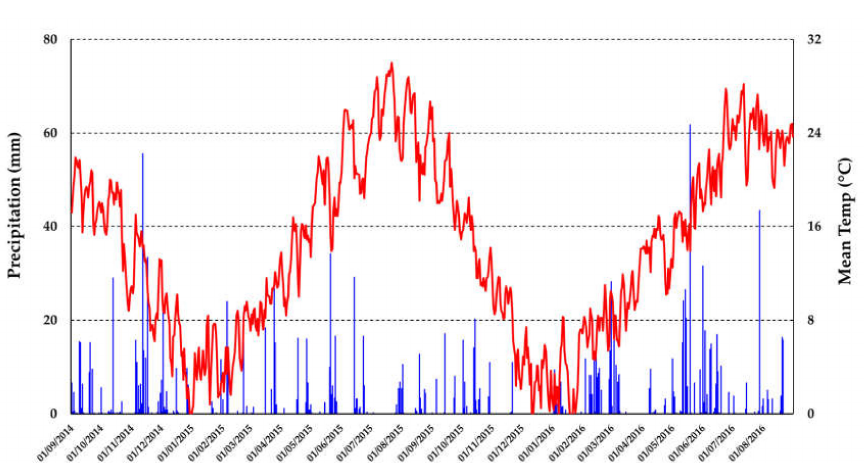
Figure 2. Meteorological data recorded during the two years of tests: daily precipitation recorded at the test site (rain gauge with tipping bucket, area 200 cm 2 ) and mean daily temperature recorded at the meteorological station of the Regional Agency for Environmental Protection and Prevention of Veneto (ARPAV), located 0.5 km from the test site.